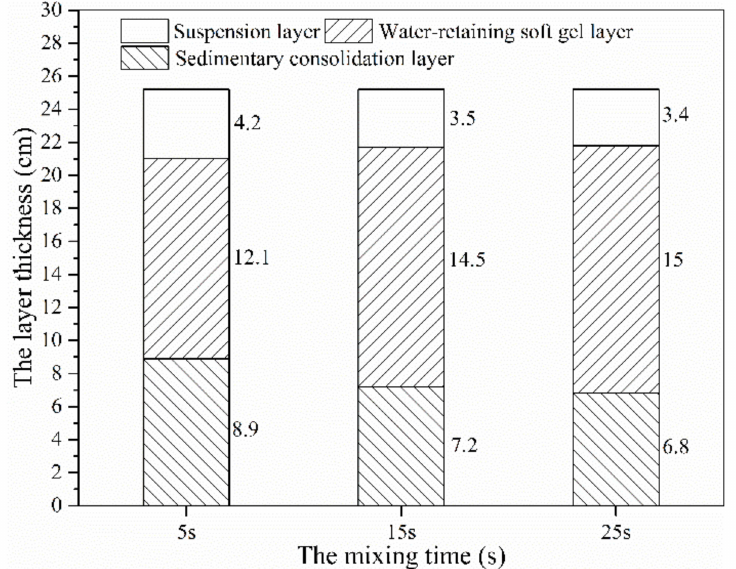
Figure 6. Deposition thicknesses of CSG in water with different initial mixing